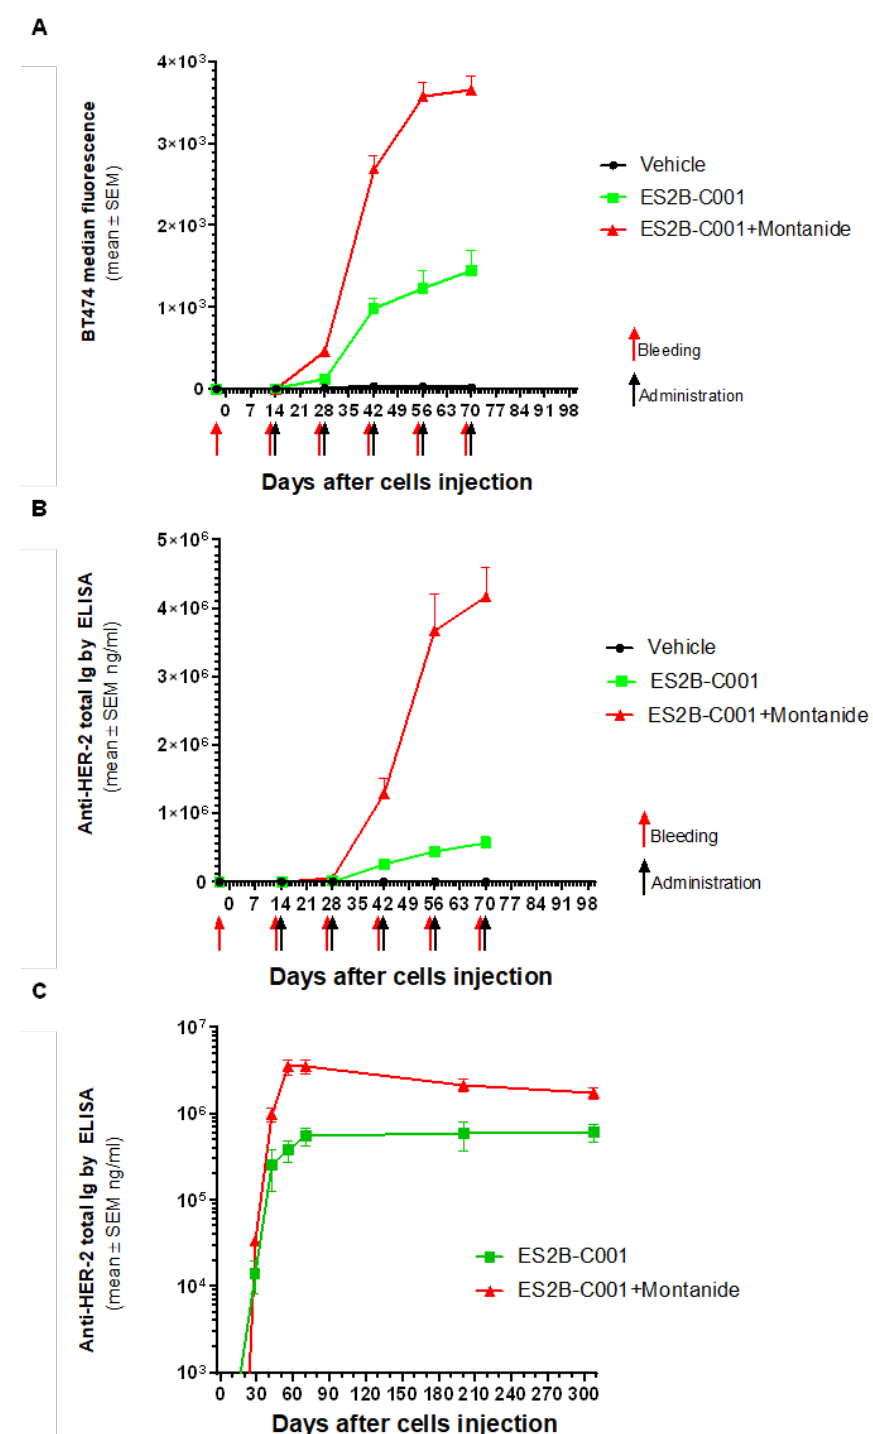
Figure 3. Antibodies elicited in FVB mice by ES2B-C001 therapeutic vaccinations, as measured by flow cytometry of human HER-2 +++ BT-474 breast cancer cells ( A ) and by ELISA on human HER-2 extracellular domain ( B ). Each point represents the mean (and SEM) of mouse groups shown in Figure 1. ELISA titles were compared by Tukey’s test: p < 0.05 vehicle vs. ES2B-C001 at day 70, p < 0.0001 vehicle vs. ES2B-C001+Montanide and ES2B-C001 vs. ES2B-C001+Montanid from day 42. ( C ) Long-term persistence of anti-HER-2 antibodies in vaccinated mice after 7 repetitive vaccinations. Each point represents the mean (and SEM) of 3 representative long-surviving mice tested over a period of 10 months.